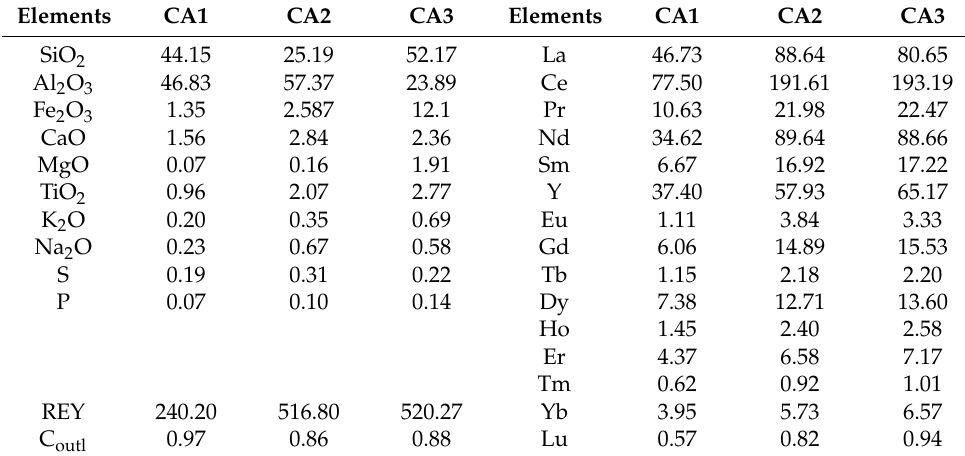
Table 1. Chemical composition of three coal ash samples (%, µ g/g).